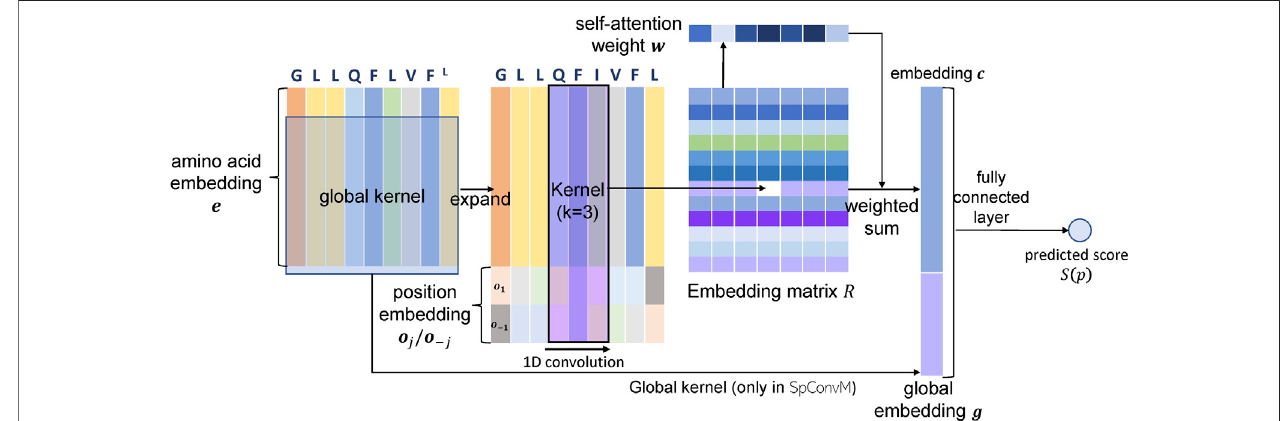
FIGURE 1 | Architectures of ConvM and SpConvM